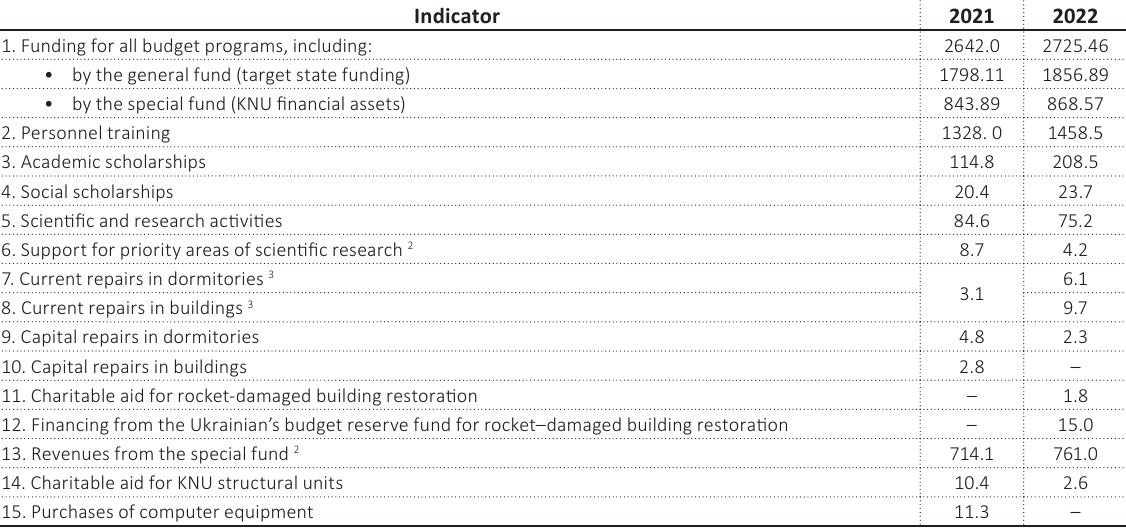
Table A1. War impacts on the educational sphere in Ukraine